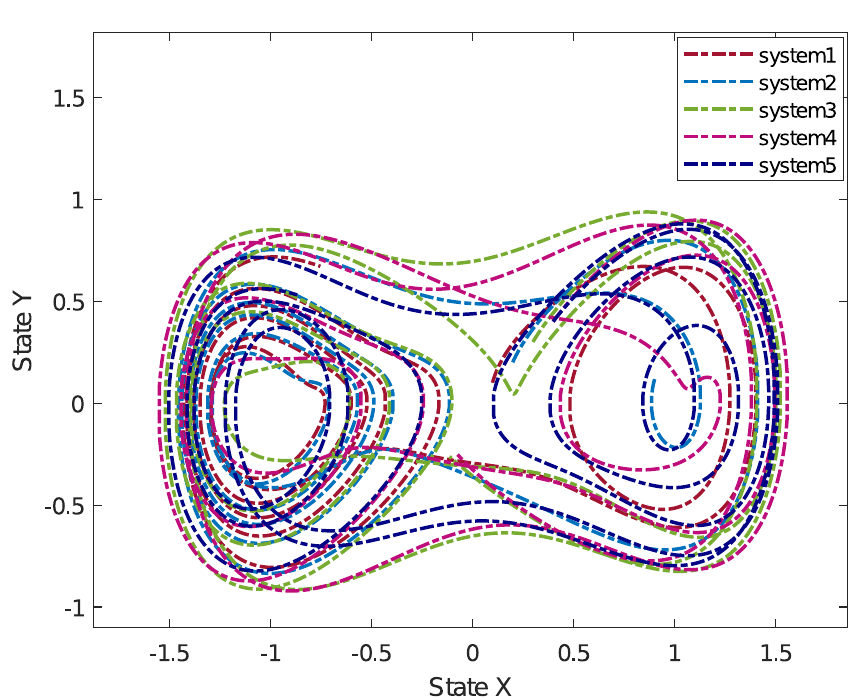
Figure 2. Fractional order Duffing-Holmes chaotic systems